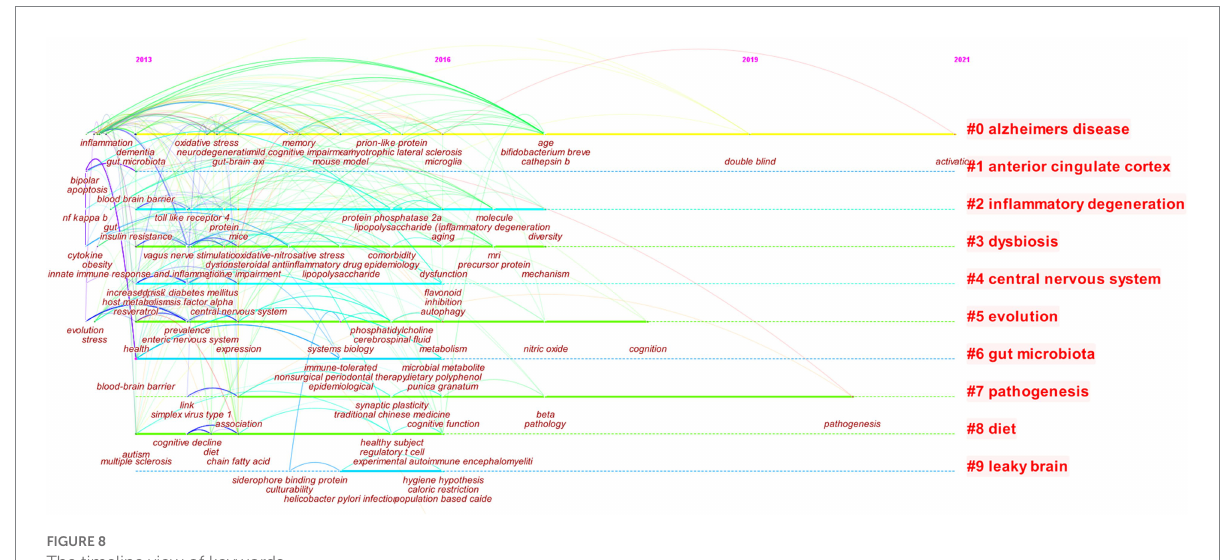
FIGURE 8 The timeline view of